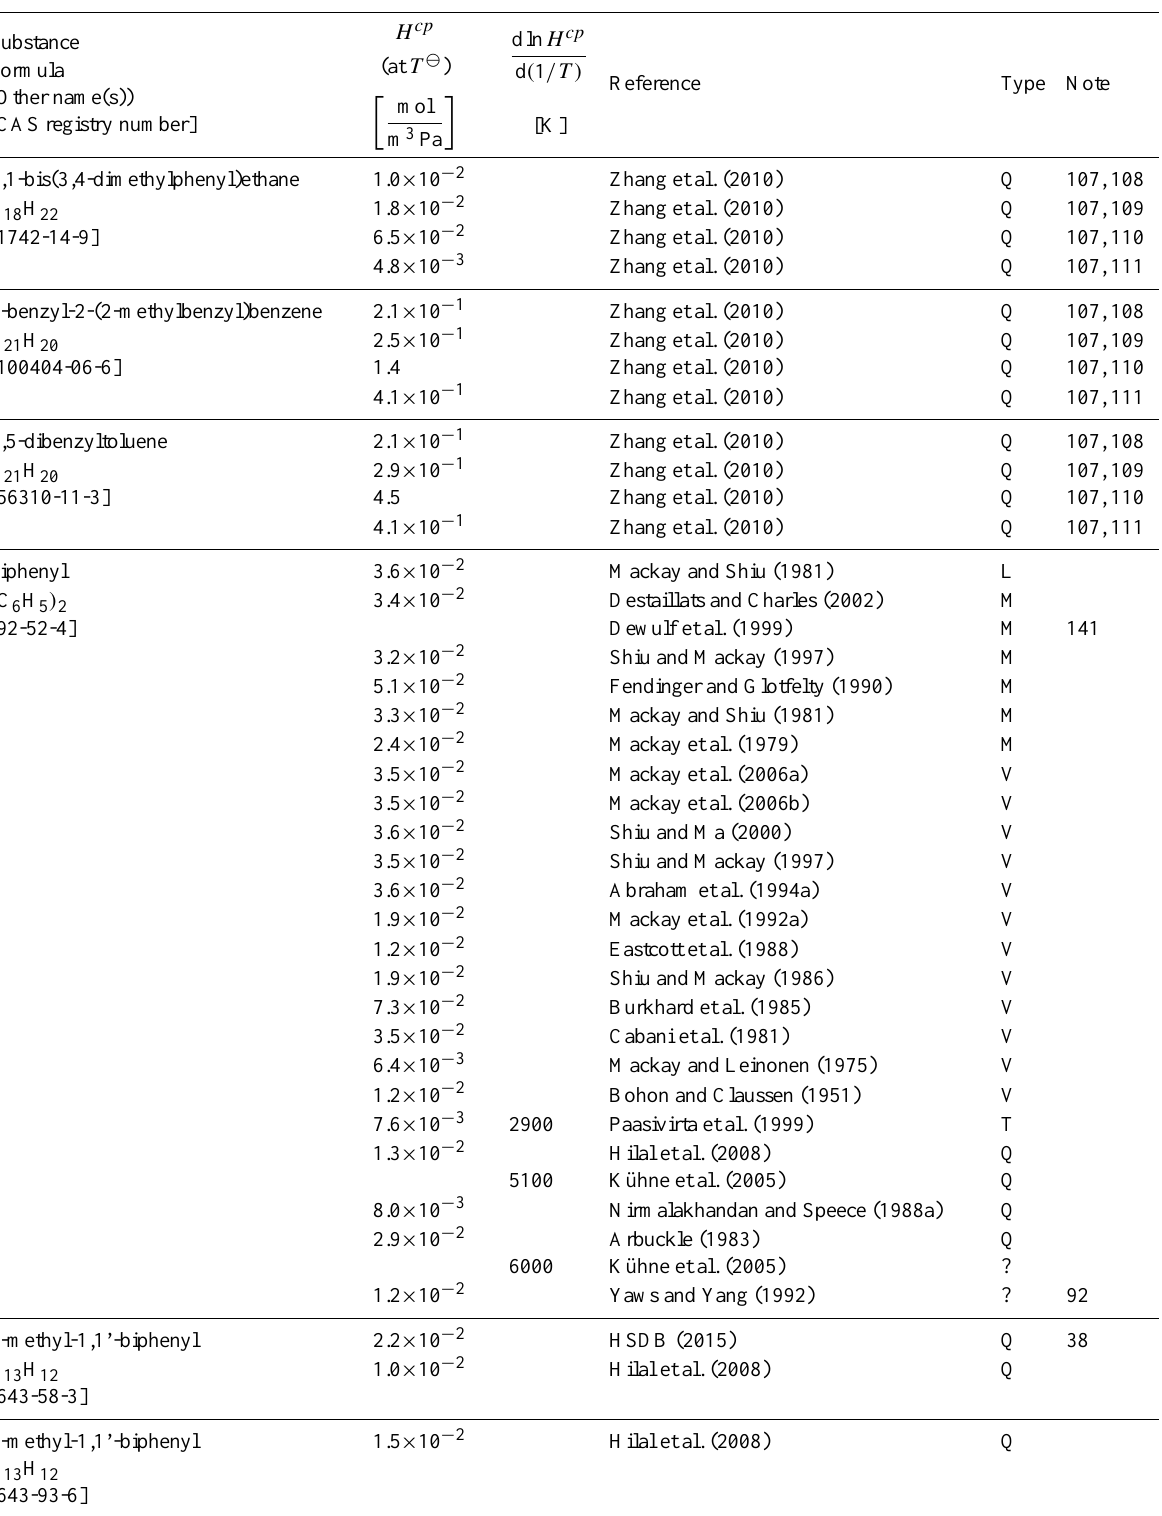
Table 6: Henry’s law constants for water as solvent